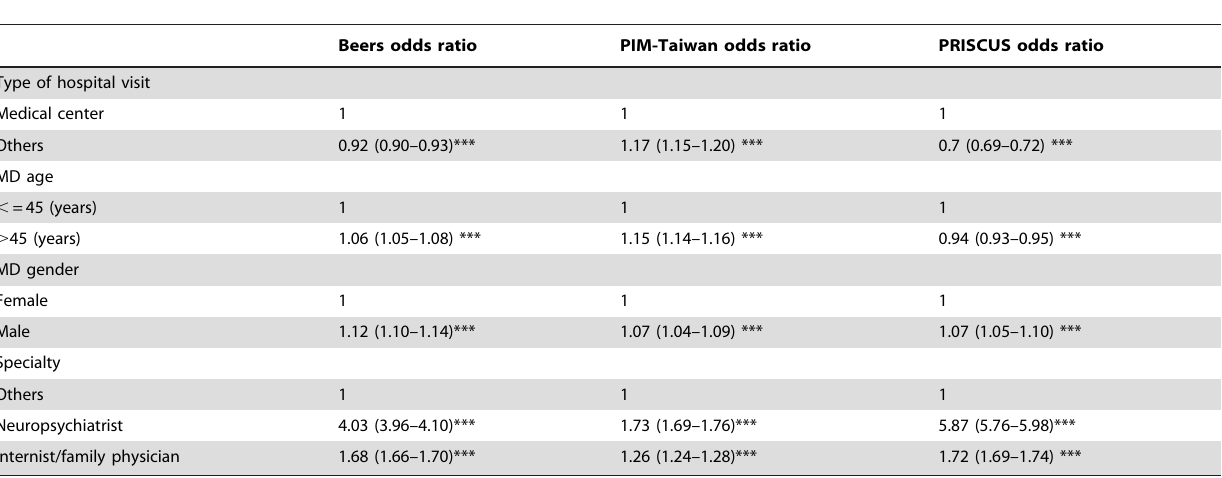
Table 6. Multivariate logistic regression for having at least one potentially inappropriate medication in one clinic visit. Beers odds ratio PIM-Taiwan odds ratio PRISCUS odds ratio